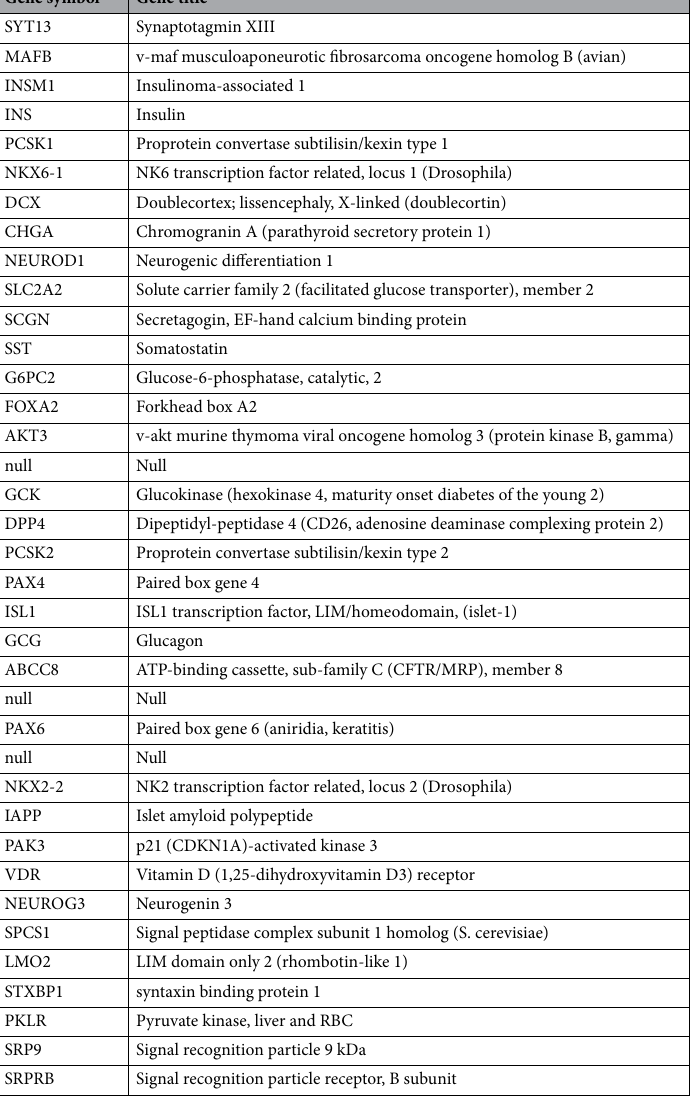
Table 3. Genes in the pancreatic β-cell gene set. a The gene symbols and gene titles of the GSEA pancreatic β-cell gene set are